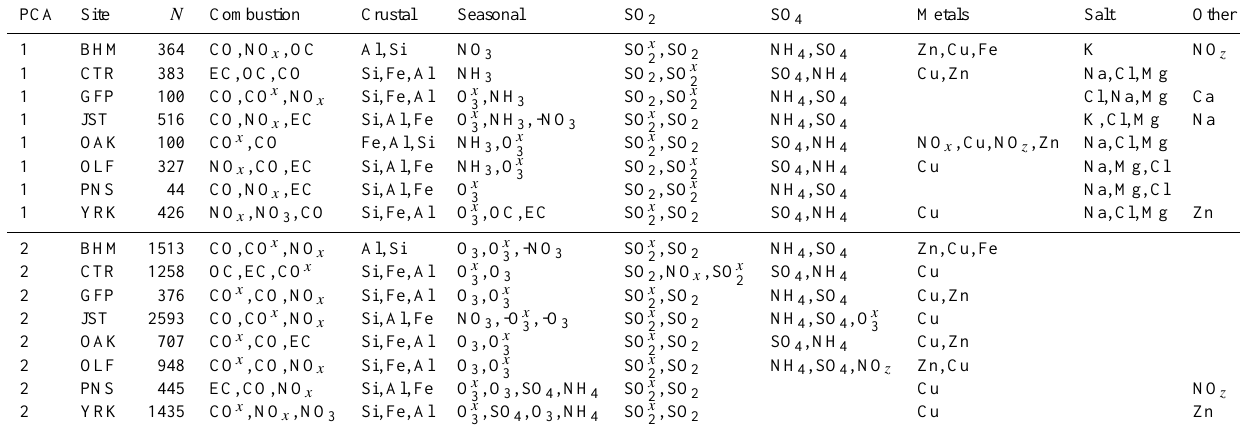
Table 2. Species associated with each PCA factor (component). Component names are keyed to the species. Three species are listed in decreasing order of association for associations of 0.6 or greater (or − 0.6 or smaller). Negative values indicate anti-correlation. CO x and are 1h daily maximum CO and SO 2 , respectively. O x is 8h daily maximum O 3 . PCA1, 2008–2013; PCA2, 1999–2013. N is number SO x 2 3 of days.